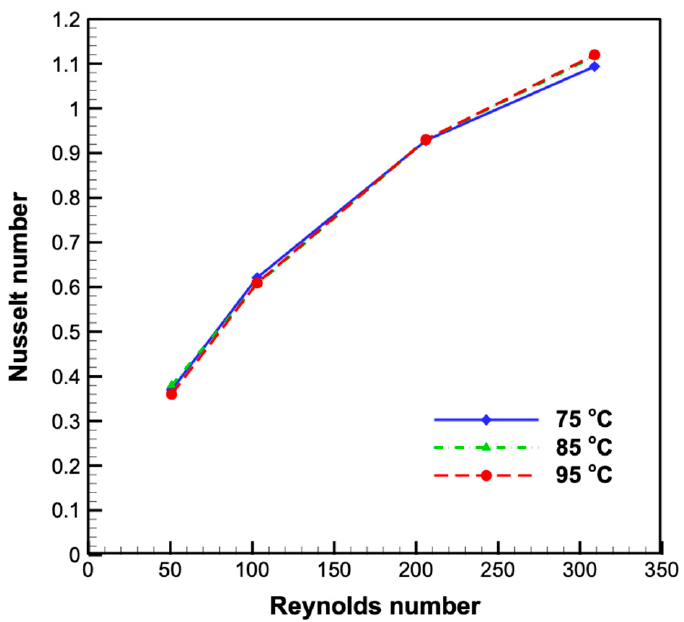
Figure 8. Nusselt number with different inlet temperatures for different Reynolds numbers.